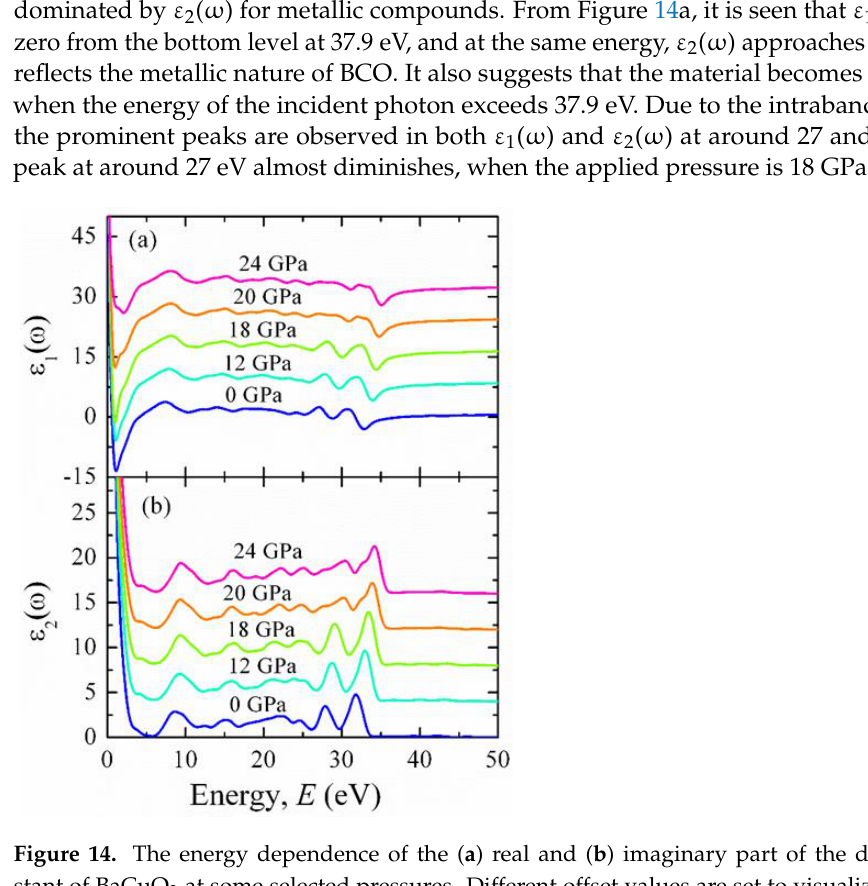
Figure 15. Partial DOS of Cu-3d and O-2p orbitals at 16, 18, 20, and 24 GPa.